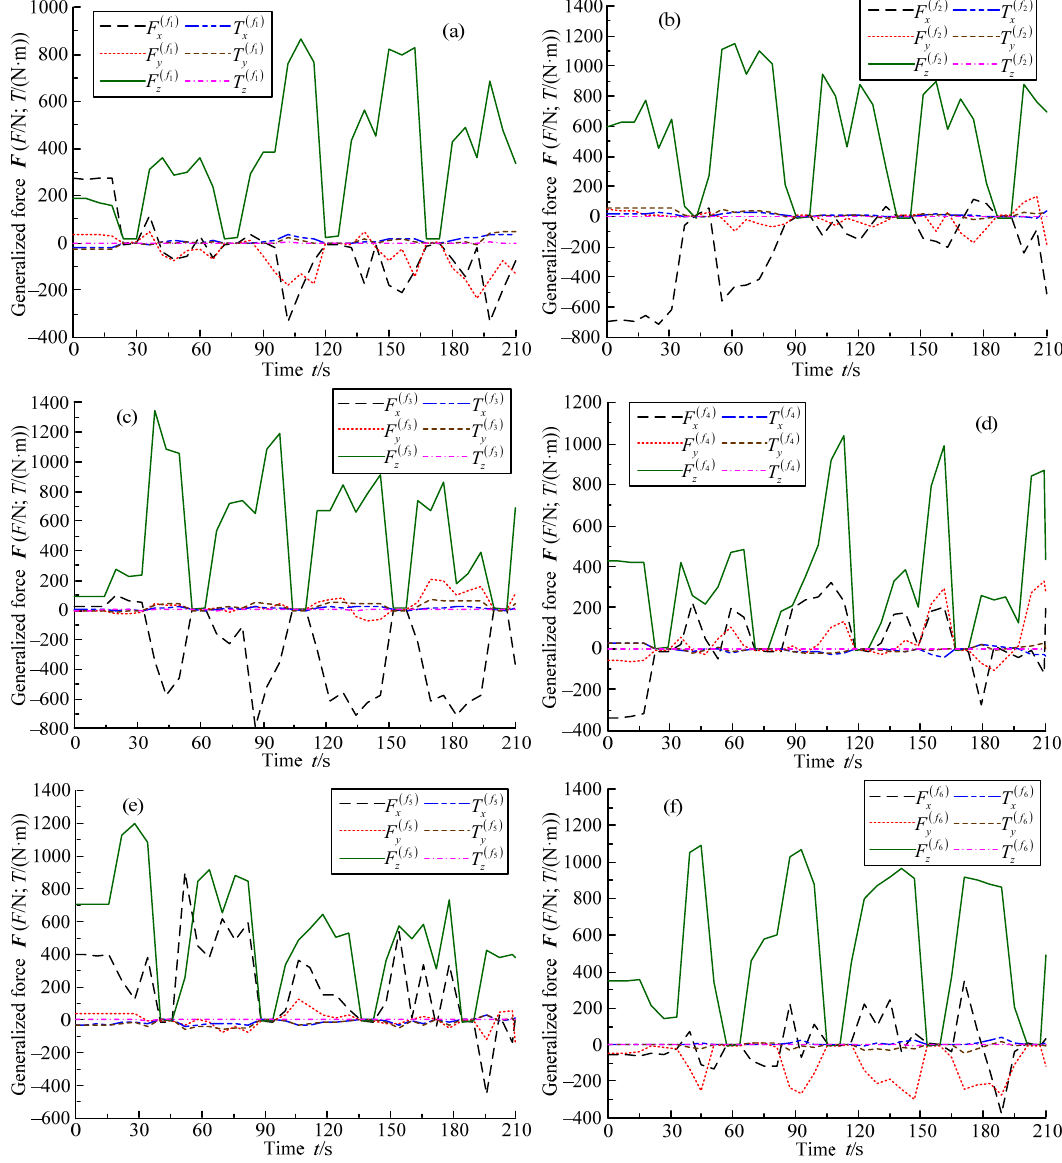
Figure 26. Generalized force curves of feet: ( a ) leg 1; ( b ) leg 2; ( c ) leg 3; ( d ) leg 4; ( e ) leg 5; and ( f ) leg 6.